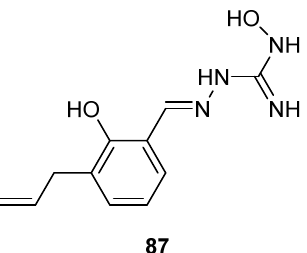
Figure 11. Modified 3-hydroxyguanidines antiviral Schiff base.